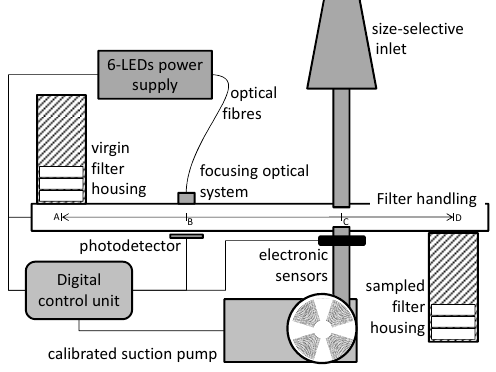
Figure 1. Schema of CleAir apparatus.